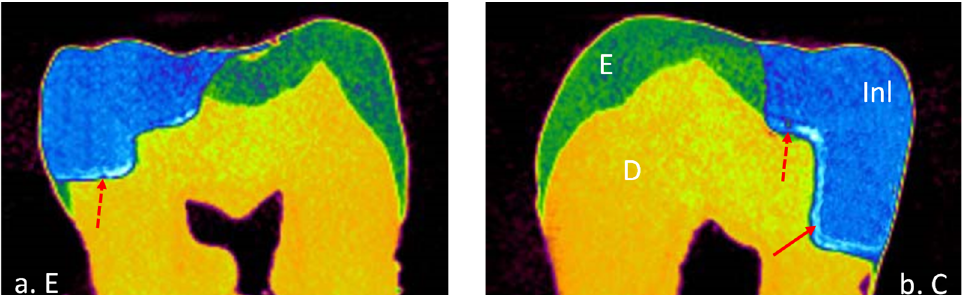
Figure 3. Micro-CT images of internal and marginal gap at the gingival floor of a Class II Lava Ultimate inlay luted with e Cement resin cement on ( a ) enamel and ( b ) cementum/dentin. Adhesive layer contains: solid arrow, silver deposits; dotted arrow, void.